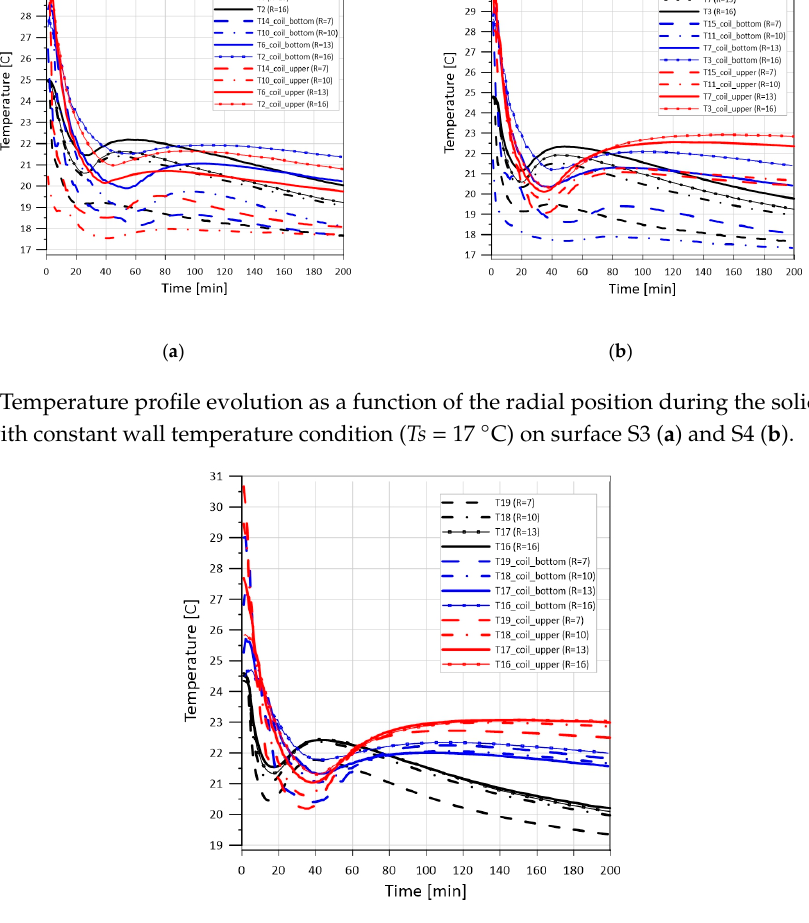
Figure 9. Temperature profile evolution as a function of the radial position during the solidification process with constant wall temperature condition ( Ts = 17 °C) on surface S5.